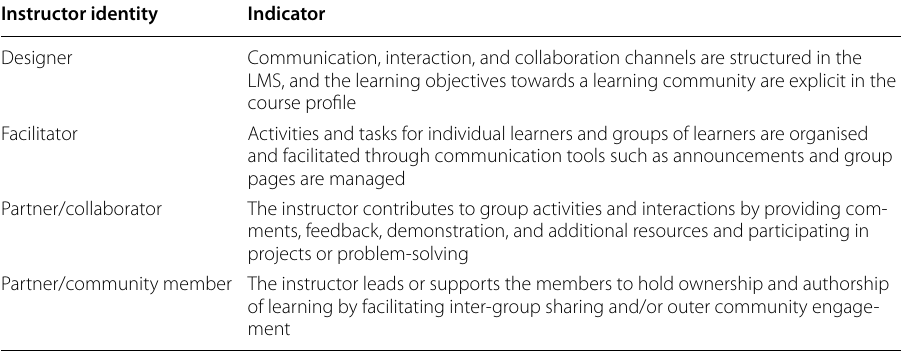
Table 2 Evaluation indicators of instructor identity changes